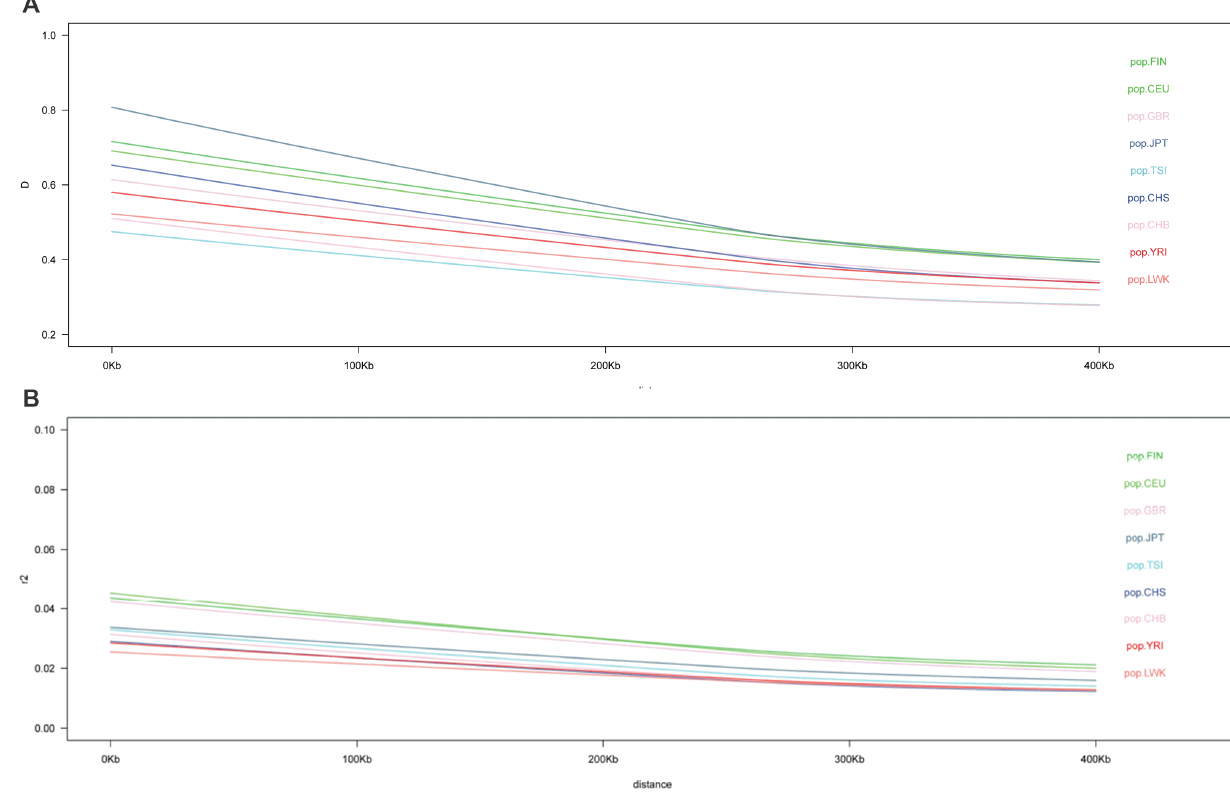
Figure 3. Across sample comparison linkage disequilibrium as a function of pairwise distance between SNPs for similar number of individual (n=85) as measured by D 9 (A) and R 2 (B). (A) Across sample comparison of Median of LD (D 9 ) as a function of pairwise distance between SNPs for similar number of individual (n=85) . (B) Across sample comparison of Median of LD (R2 9 ) as a function of pairwise distance between SNPs for similar number of individual (n=85) . We resampled 85 unrelated individuals from the various populations of the 1000 Genomes in order to compare the LD decay pattern for a similar sample size. The figure shows the relation between the median percentile of pairwise LD measures according to the distance between the two markers between 0 and 400 Kb.